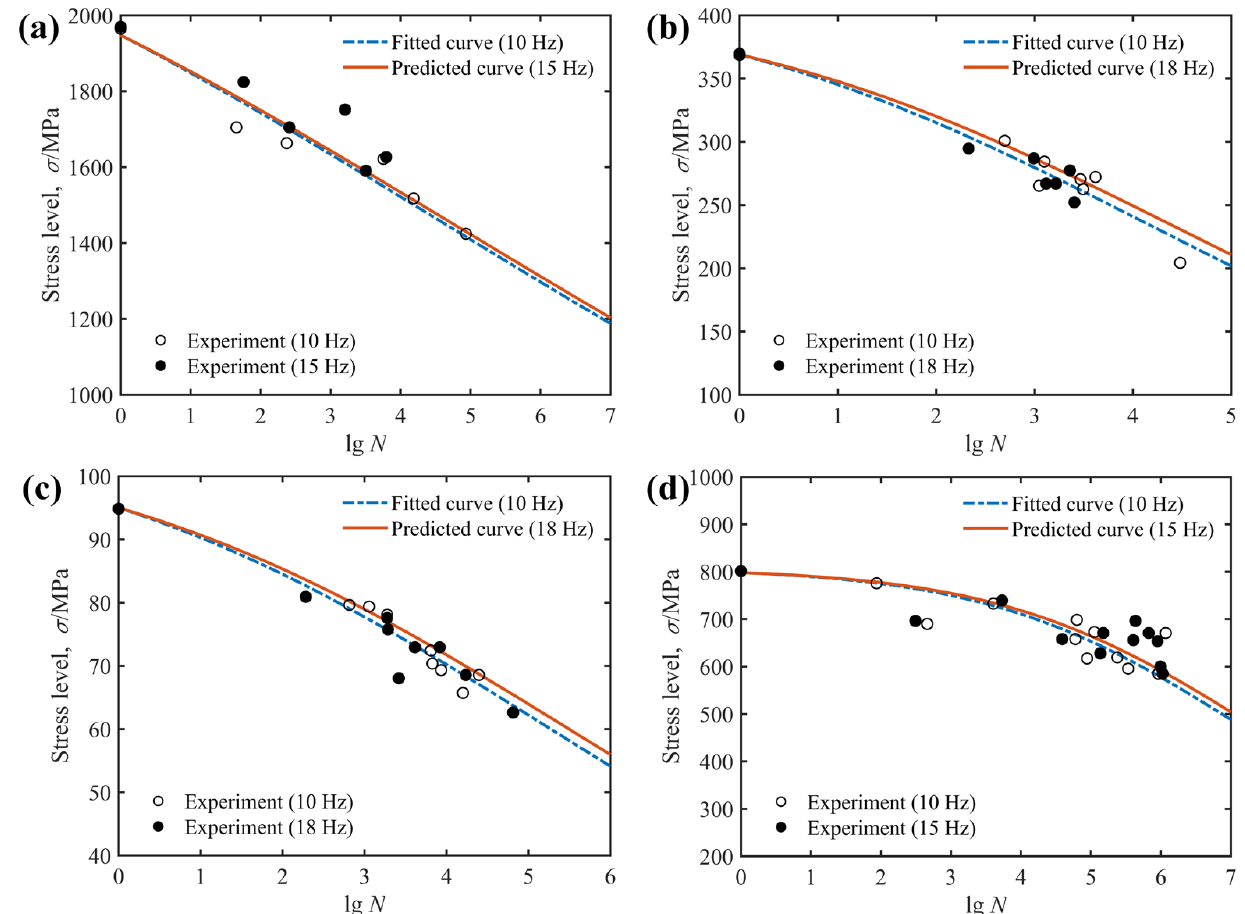
Figure 9. Fitted and predicted S - N diagrams of graphite/epoxy specimens based on experimental data from Ref. [35]: ( a ) [0 ◦ ] 4 ; ( b ) [15 ◦ ] 4 ; ( c ) [45 ◦ ] 4 ; ( d ) [0 ◦ /90 ◦ ] 3 . Table 6. Determination of model parameters considering loading frequency effect. Loading Frequency f Materials and Layup Configuration